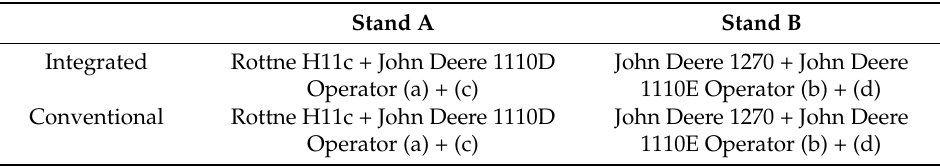
Table 1. Experimental design of the